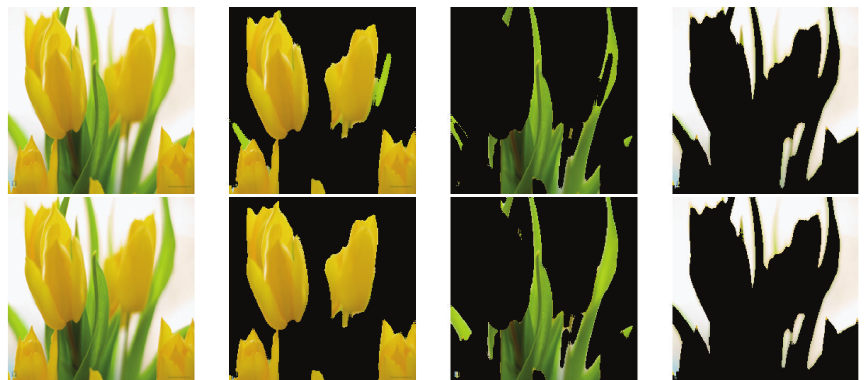
Figure 6: Natural image segmentation after thresholding. From left to right: original image and three phases of hard segmentations. Line 1: Shen’s model. Line 2: proposed model.